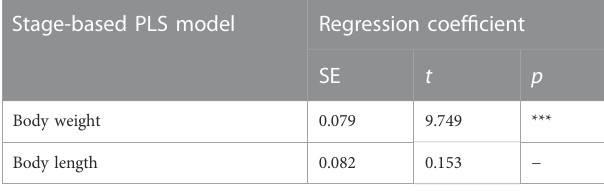
TABLE 4 PLS regression coef fi cient signi fi cance